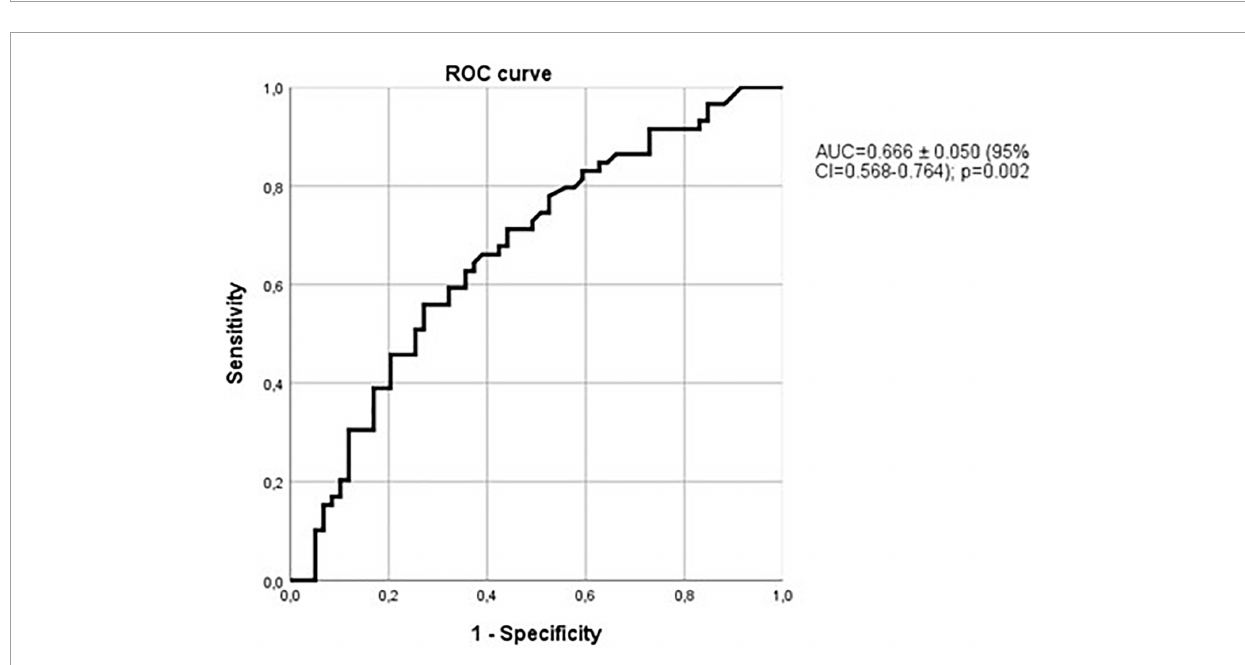
FIGURE10 Relationship between sclerostin and cella media values over the median. ROC curve with an AUC = 0.666 ± 0.050 (95% CI = 0.568–0.764); p =